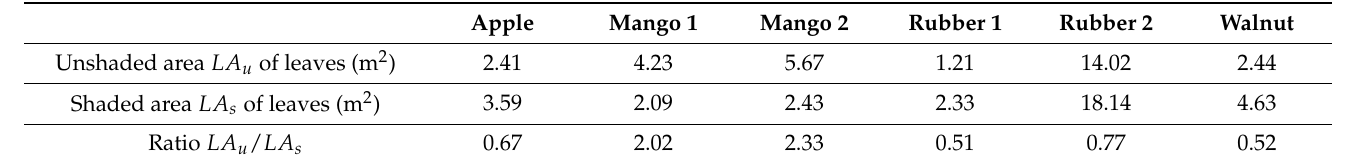
Table 4. Unshaded and shaded area of leaves for each tree in the modeling forest plot with the specific sun position at 12:00 on 10 September 2022 in Nanjing. Apple Mango 1 Mango 2 Rubber 1 Rubber 2